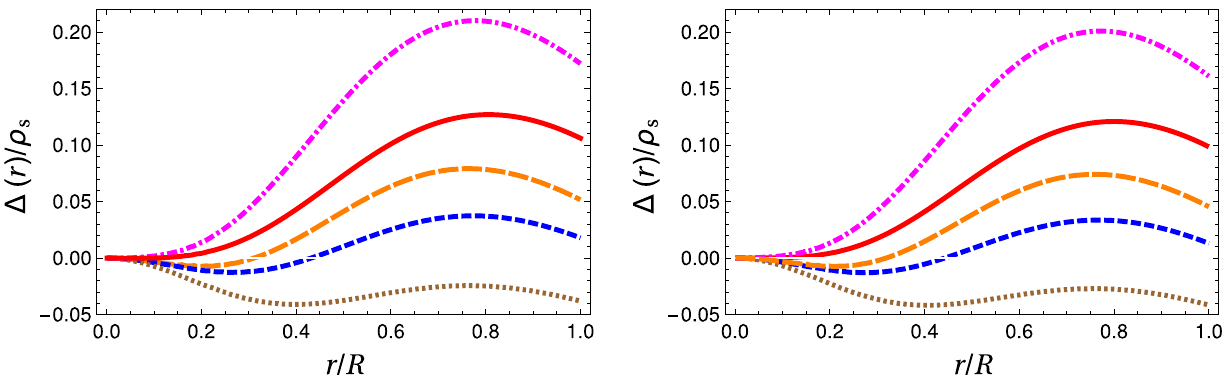
red line), (ii) Solution 2 (short dashed blue line), (iii) Solution 3 (dotted brown line), (iv) Solution 4 (dot-dashed magenta line), (v) Solution 5 (long dashed orange line). Right: Same as left panel, but for solutions 1–5 corresponding to the case G (cid:5) ( r = 0 ) = + 0 . 0002 / km (Table 2)